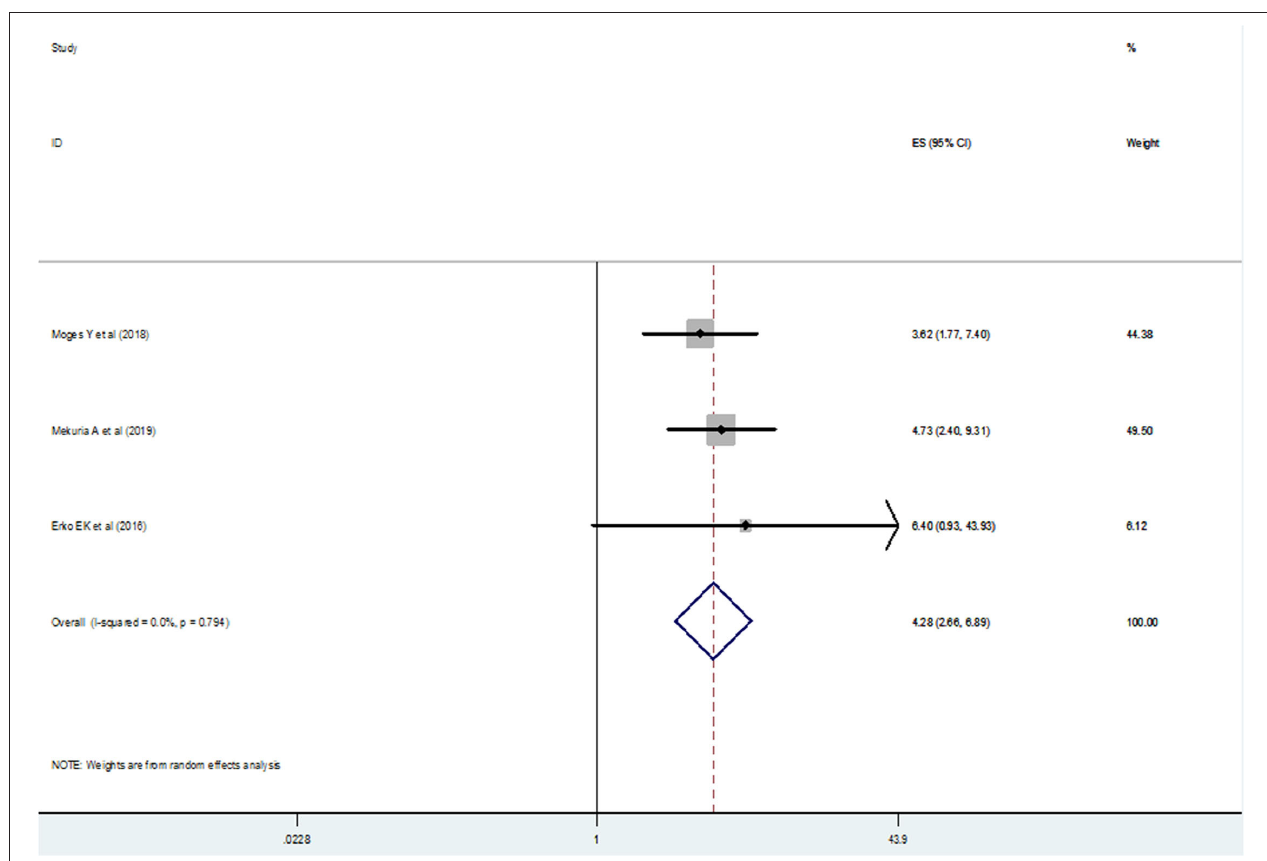
FIGURE 11 | The pooled odds ratio of the association between previous utilization of family planning by mothers and post-abortion contraceptive utilization in